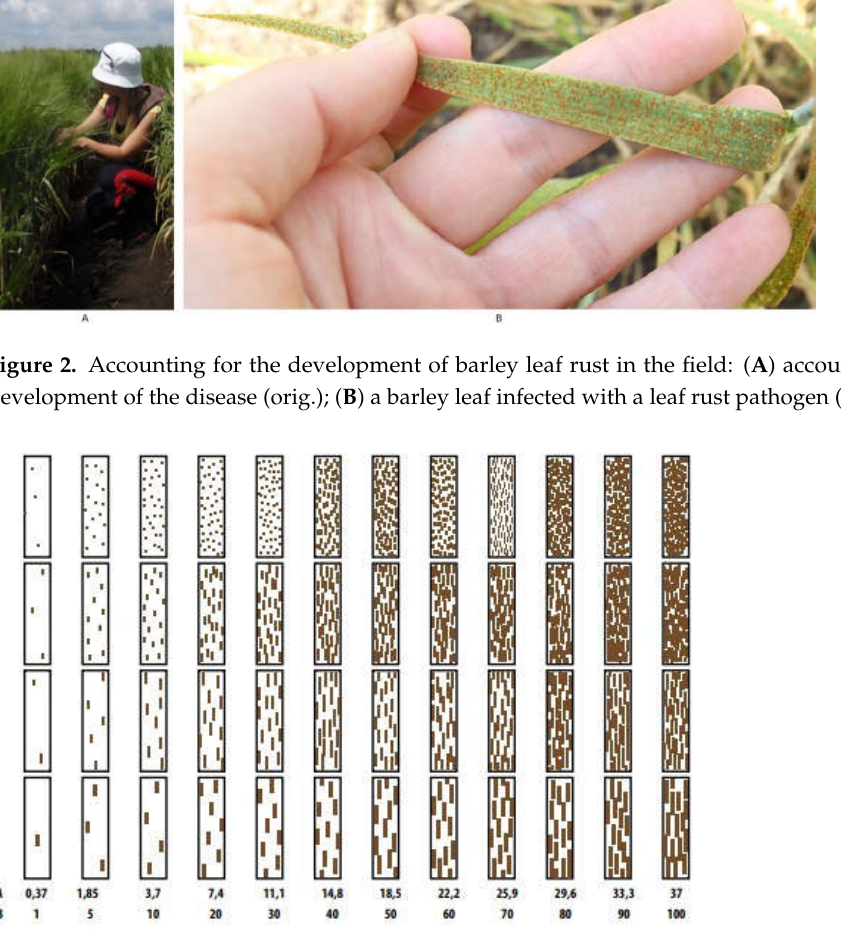
Figure 3. A scale for accounting for the infestation of cereals with types of rust (CIMMYT) [29,30]. Note: A—the actual area of the sheet covered with rust pustules, %; B—the degree of rust damage according to the modified Cobb scale.